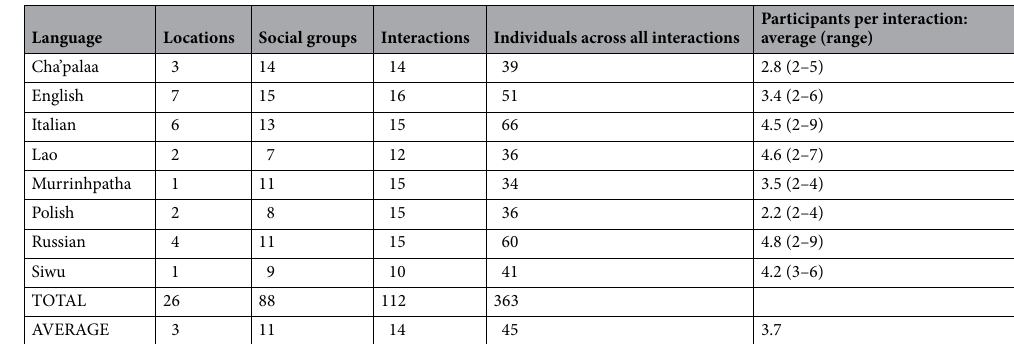
Table 4. Sampling. Number of locations (villages, towns, or cities), social groups, and interactions sampled; total number of individuals across all sampled interactions; and average number of participants per